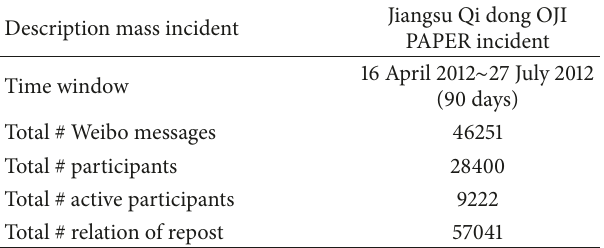
Table 1: Data collected from Jiangsu Qi dong OJI PAPER incident.